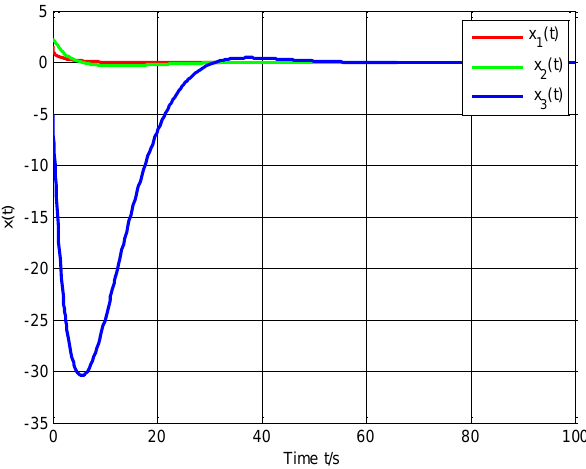
Figure 2. State response of the closed − loop system for Example 2.